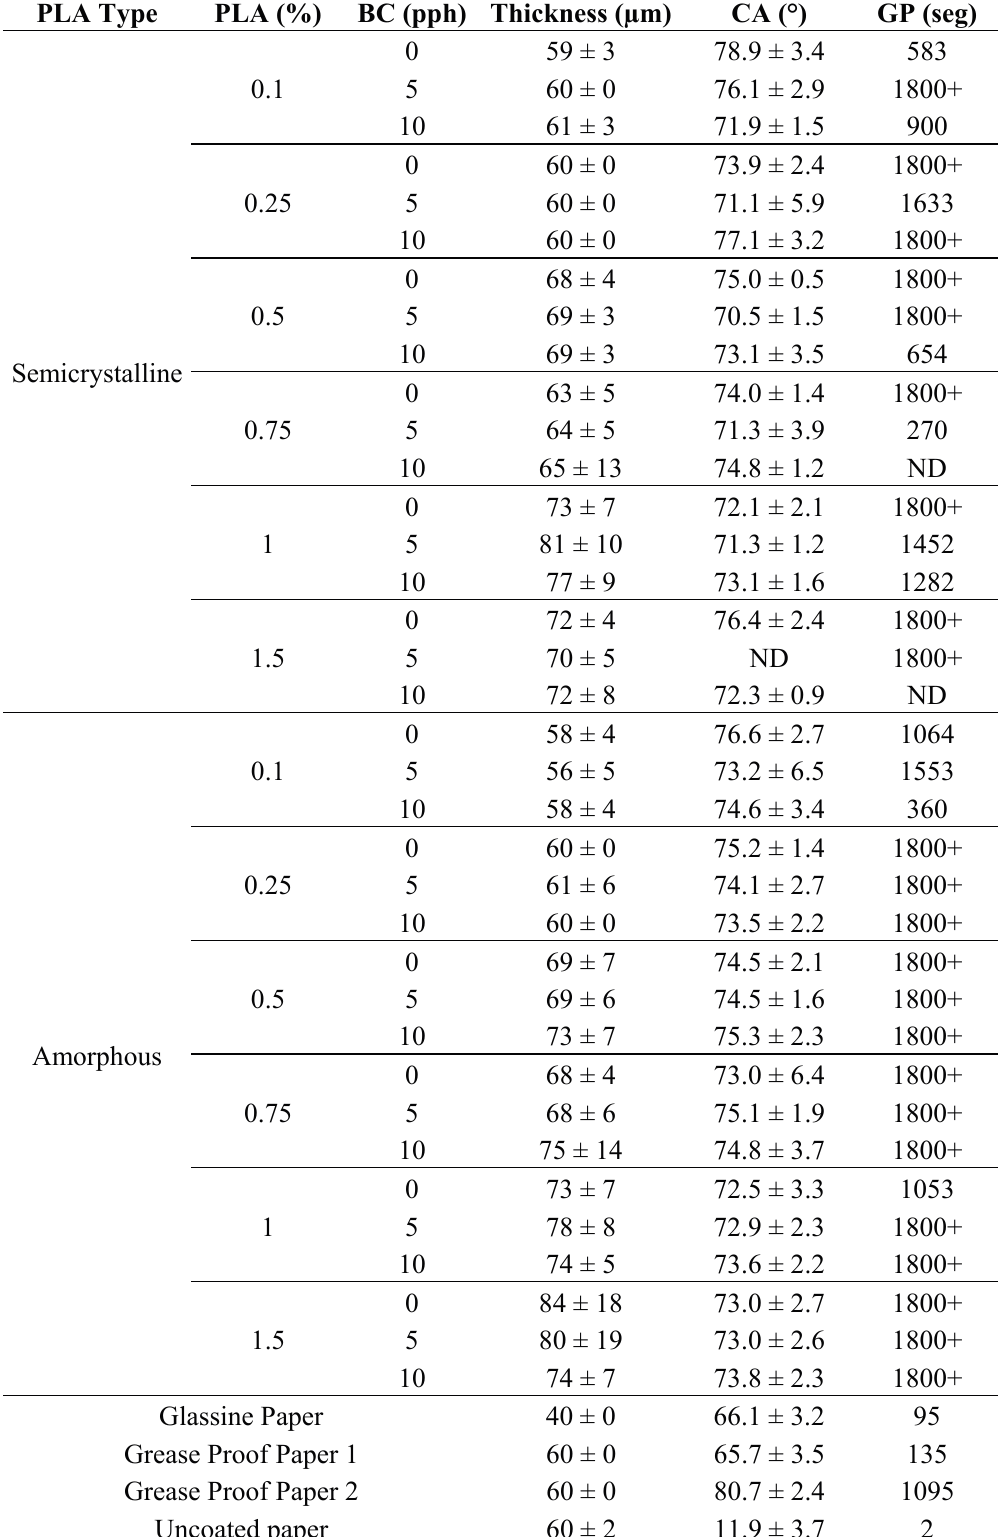
Table 1. Thickness, CA and grease resistance of coated, uncoated and references